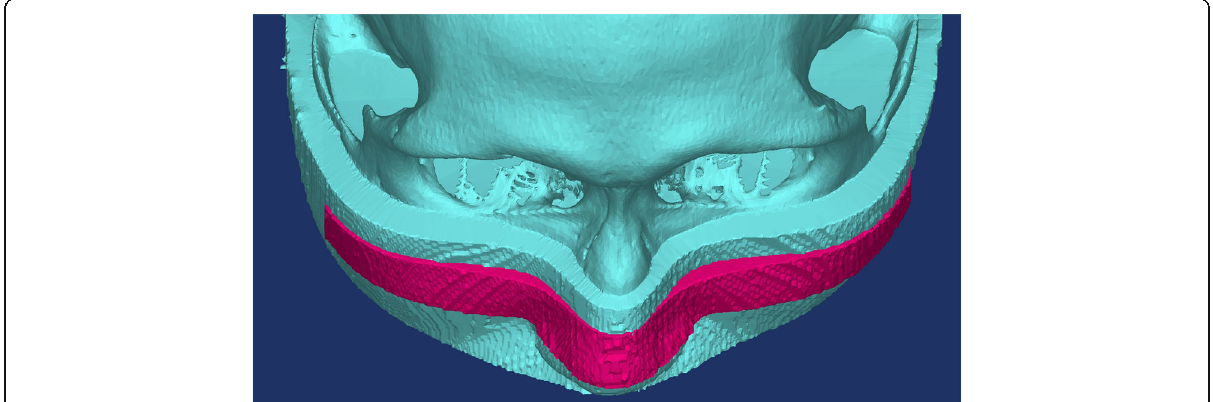
Fig. 4 Differences (red) in facial volumes between preoperative (blue) and postoperative facial 3D-reconstructed CT data used to measure the amount of midfacial swelling with a 3D model after a Le Fort I